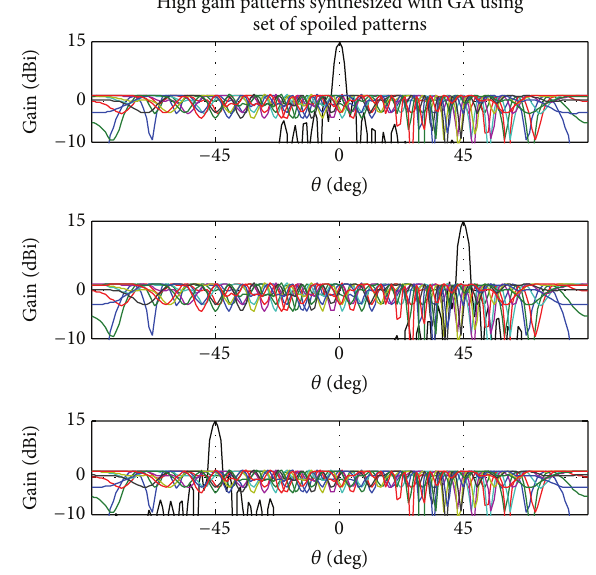
Figure8:SynthesisofhighgainbeambyGAcalculatedweightswith fixed 𝑁 = 32 and 𝑅 = 8 km.